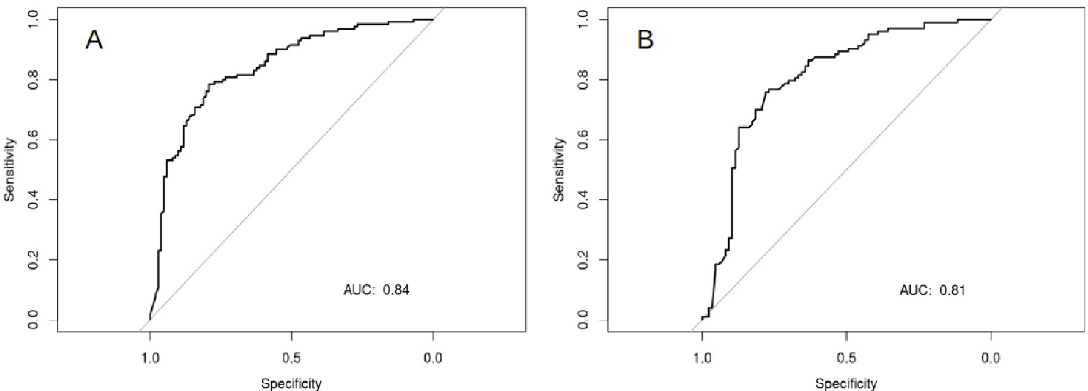
Fig 3. The ROC curves of the independent test set for the model predicting the reliability 1 year (A) and 2 years (B) post-diagnosis.